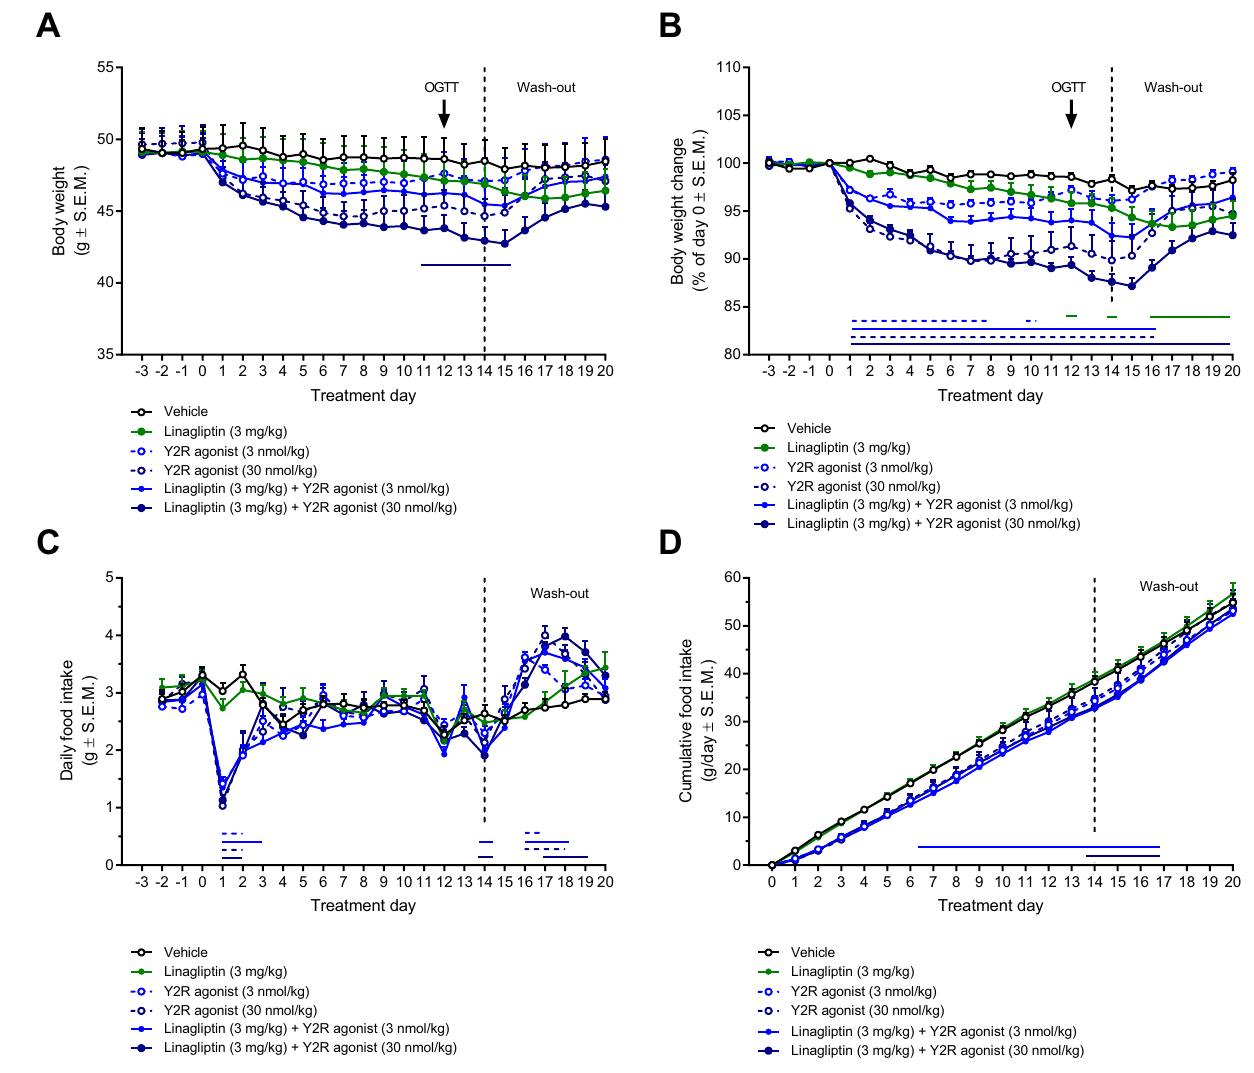
Figure 4. Linagliptin does not augment Y2R receptor agonist-induced food intake inhibition and weight loss in DIO mice. Linagliptin (3 mg/kg, SC) and long-acting Y2 receptor agonist (PYY analogue, 3 or 30 nmol/kg, SC) was administered once daily for 14 days followed by 6 days of wash-out (no treatment) before study termination. (A) Absolute body weight. (B) Body weight change (relative to day 0). (C) Daily food intake. (D) Cumulative food intake. Horizontal lines denote significant change in body weight compared to vehicle control (p < 0.05, two-way ANOVA with Dunnett’s post-hoc test). Compared to Y2R receptor agonist monotreatment, combined linagliptin and Y2R receptor agonist administration did not promote further changes in body weight and daily food intake (p > 0.05, two-way ANOVA with Dunnett’s post-hoc test) . Compensatory overeating was observed following treatment